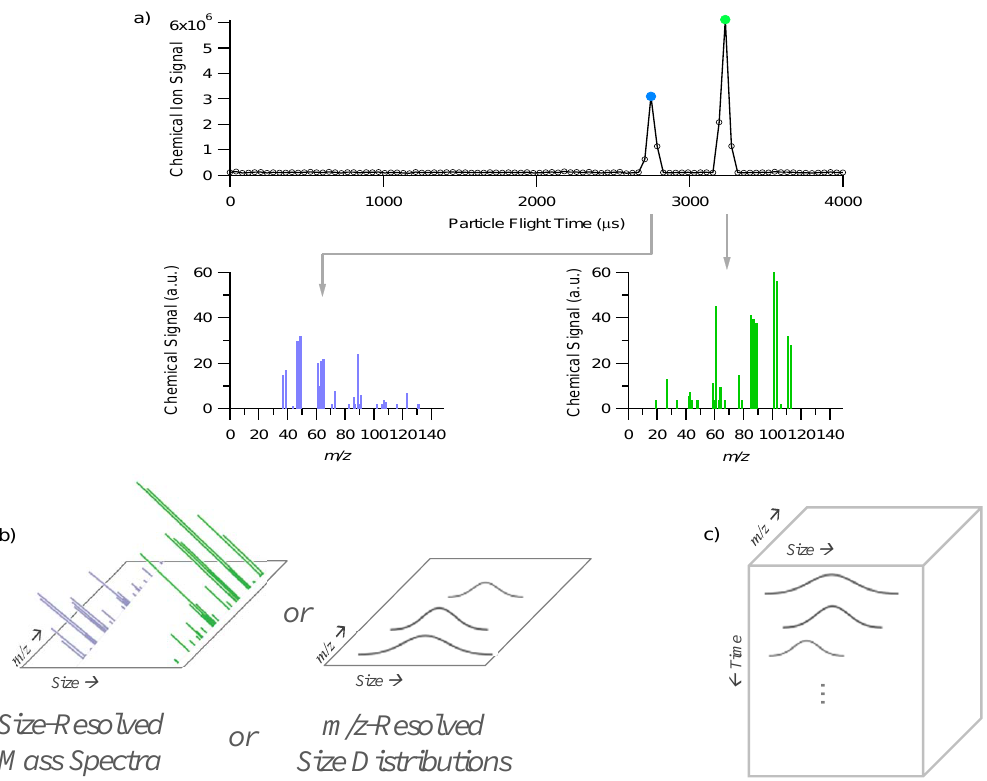
Fig. 2. Schematic representation of data collection for chemically resolved particle-size-distribution data. (a) Two particles have entered the particle flight region before being vaporized and ionized. Mass spectra are collected ∼ 50 times during the particle flight time (circles). Ions from the smaller particle arrive first (blue circle), and their mass spectrum is recorded (blue spectrum). Ions from the larger particle arrive second (green circle), and their mass spectrum is recorded (green spectrum). (Adapted from Cross et al., 2009 with permission.) (b) The size-resolved mass spectra can be arranged as a 2-D matrix in which one dimension represents the mass-to-charge ( m/z ) ratio, and one dimension represents particle size. The same data could be conceptualized as m/z -resolved size distributions if the points in each m/z row are connected. (c) Over many measurement periods, the 2-D samples can be arranged into a 3-D